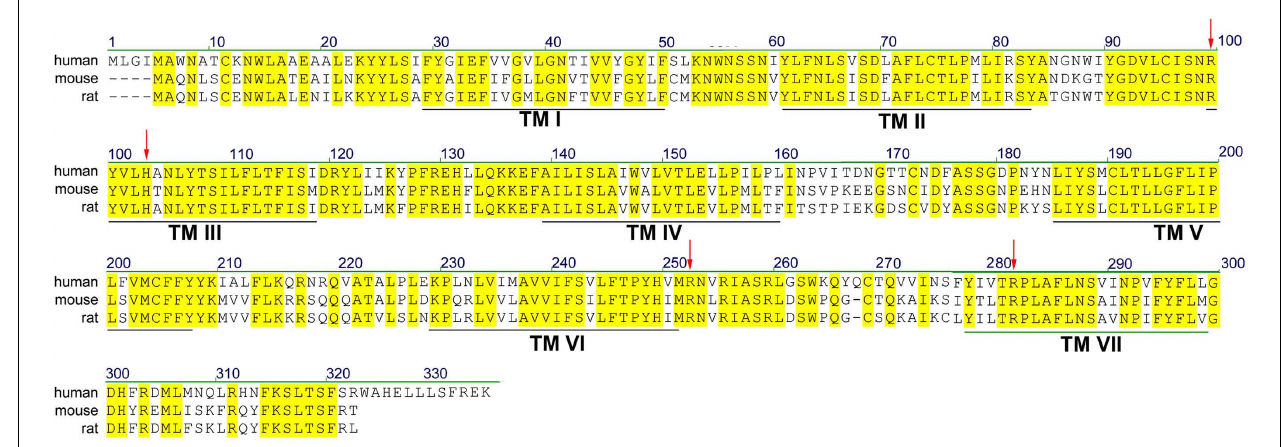
FIGURE 1 | Sequence alignment of human, rat, and mouse SUCNR1. Yellow residues are conserved between species. Predicted transmembrane (TM) domains I–VII are indicated by black lines. Residues important for succinate binding (Arg99, His103, Arg252, and Arg281) are indicated with red